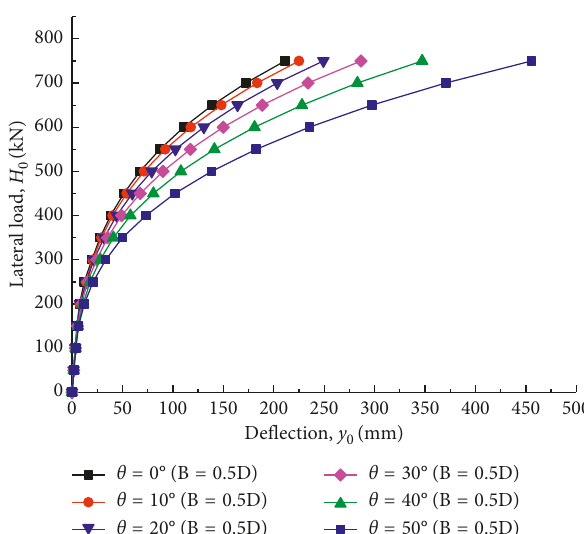
Figure 11: Maximum bending moment-load curves for different slope